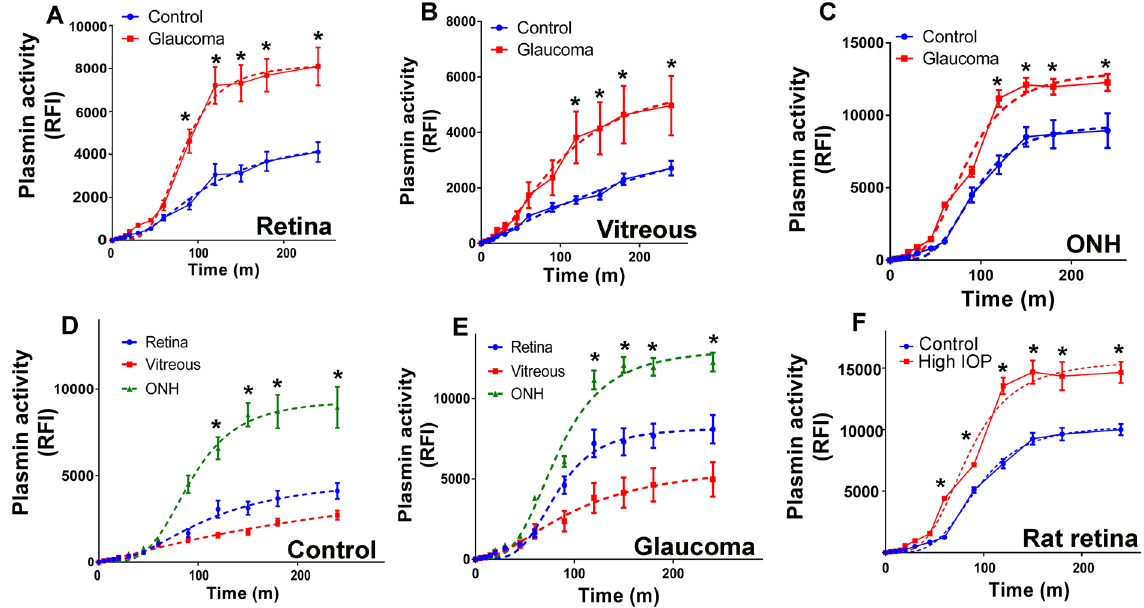
Figure 4. Plasmin proteolytic activity was measured in tissue lysates from ( A ) human retina( B ) vitreous and ( C ) ONH samples from both control (n = 12) and glaucoma eyes (n = 12) in a time dependent manner (0–300 minutes) and data plotted. Data was fitted using allosteric sigmoidal curve and regression analysis carried out. ( D–E ) Plasmin proteolytic activity change in retinal, vitreous and ONH tissues from control and glaucoma samples using data from figures A–C is re-plotted together for comparison. ( F ) Time dependent plasmin proteolytic activity changes were measured in rat retinal lysates (0–300 minutes) from control (n = 5) and high IOP (n = 5) eyes and data plotted. Dotted lines represent sigmoidal allosteric regression analysis ( * p <